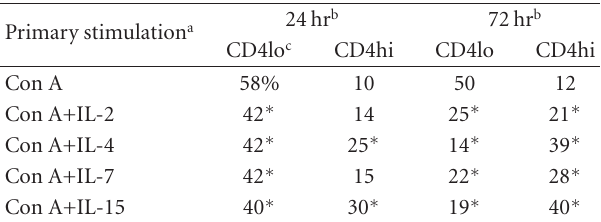
Table 2: The addition of cytokines during primary stimulation increases the transition of na¨ıve NOD T cells to CD4hi e ff